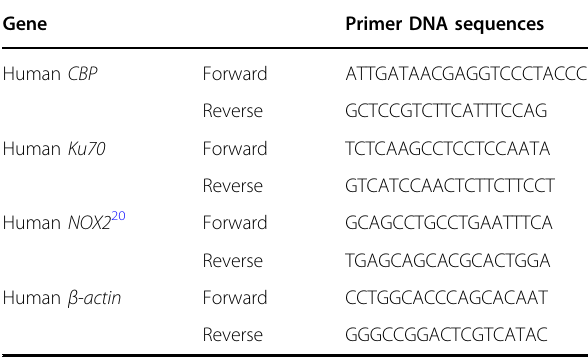
Table 2 The primer sequences for RT-PCR. Gene Primer DNA